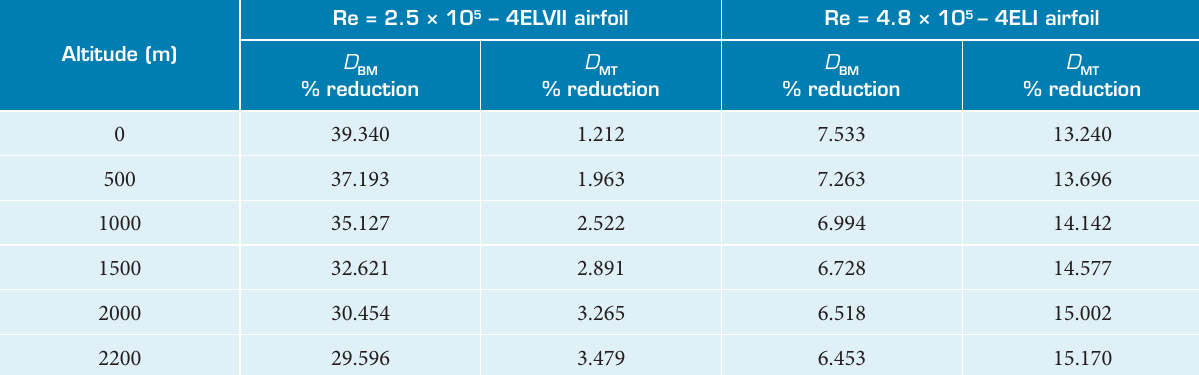
Figure 13. Drag coefficients of selected morphed airfoils with base and target airfoils at various altitudes. (a) Re = 2.5 × 10 5 ; (b) Re = 4.8 × 10 5 . Table 7. Reduction in drag coefficient of selected morphed